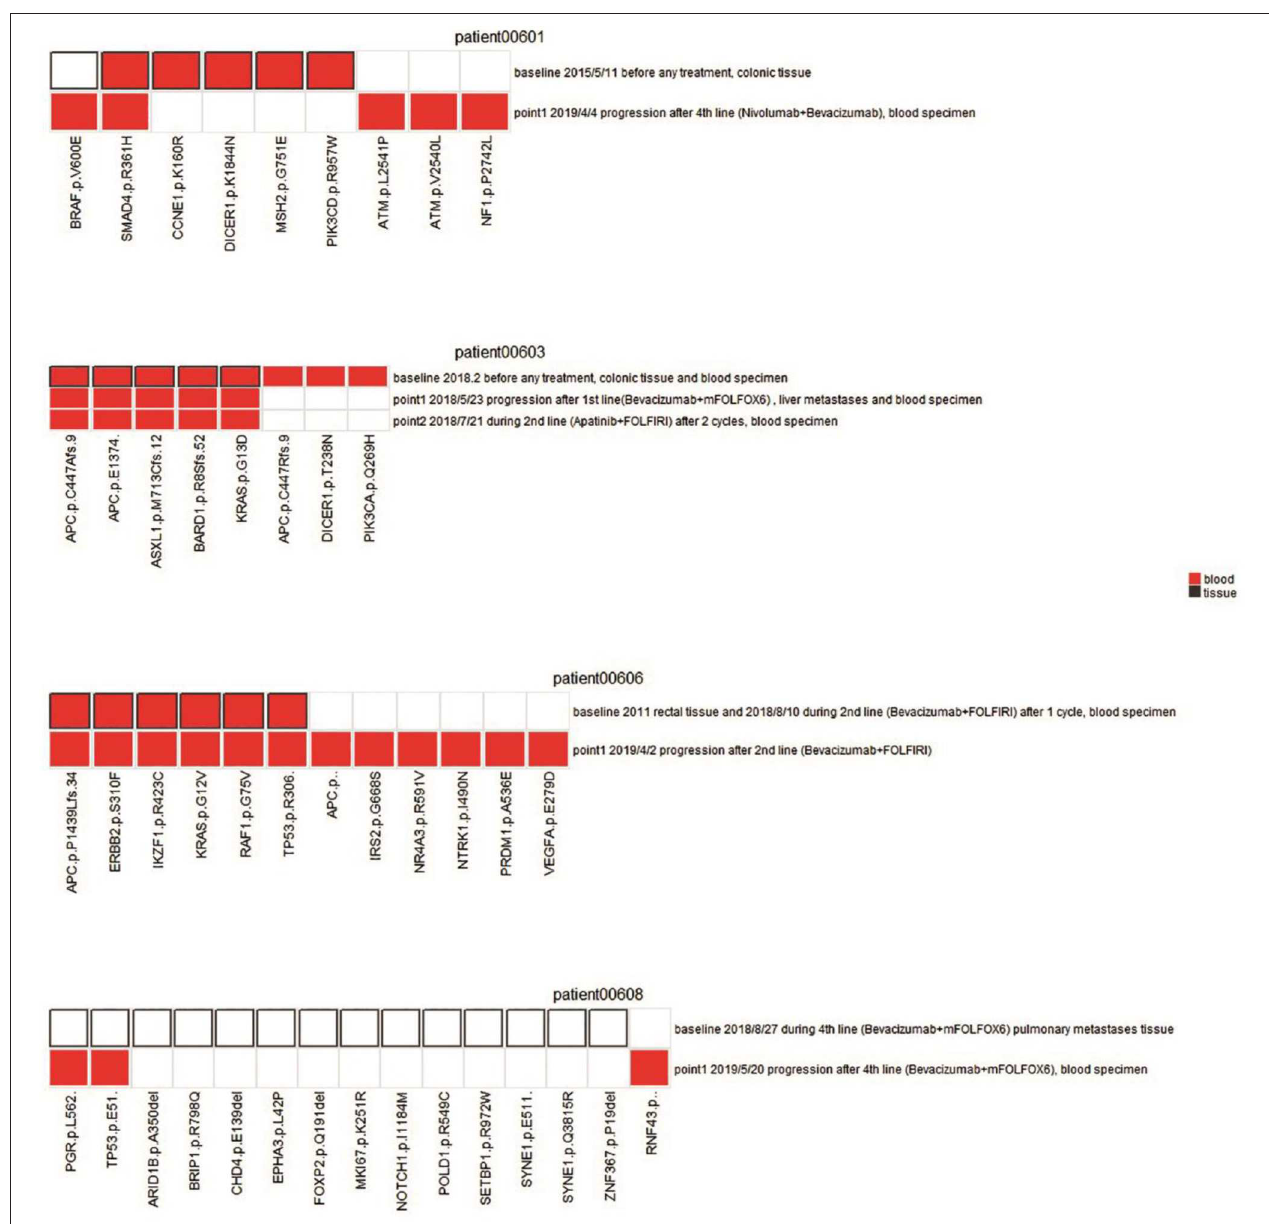
FIGURE 3 | Comparison of mutation status between plasma and tissues in four patients. Mutations for both pre-therapeutic tissue or blood samples and post-therapeutic blood samples were compared. Red squares indicate mutations from blood, and white squares with black solid border indicate mutations from tissue. Red squares with black solid border indicate mutations found in both blood and tissue. White squares with light gray border indicate no mutations.